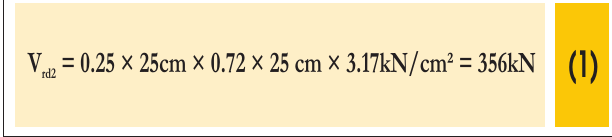
Figure 6 – Chart to assist determination of V according to NBR 6118. For the Rd determination of A has been proposed